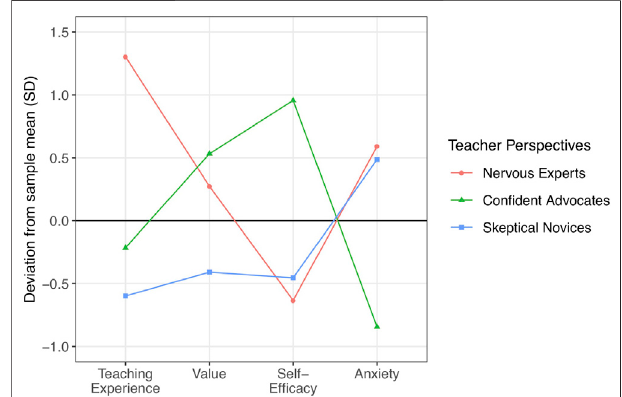
FIGURE 1 | Cluster centers of the three teacher orientations. Cluster centers resulted from the cluster analysis of 83 teachers based on their teaching experience in mathematics, their perceived value of digital tools in mathematics classrooms, their self-ef fi cacy for teaching with digital tools, and their perceived anxiety towards teaching with digital tools — measured before the